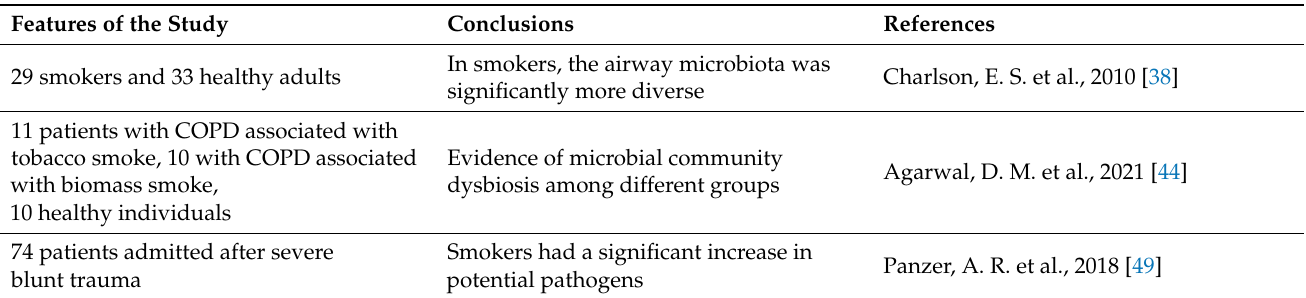
Table 4. Main studies on the link between smoking and the airway microbiota